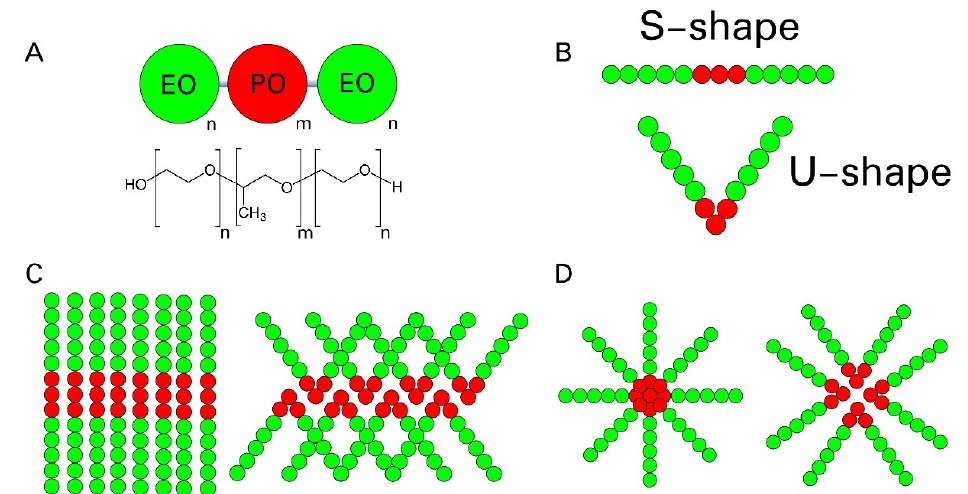
Figure 1. ( A ). Schematic representation of the coarse-grain (CG) model used in this work and chemical composition of Pluronics. ( B ). Representation of the F127 polymer in S-shape (top) and U-shape (bottom). Schematic representation of the ( C ) two lamellar (L) and ( D ) two micellar (M) cases explored in this work, composed of F127 polymers in S-shape (left, LS and MS) or U-shape (right, LU and MU) initial configuration. EO: ethylene oxide, PO: propylene oxide.